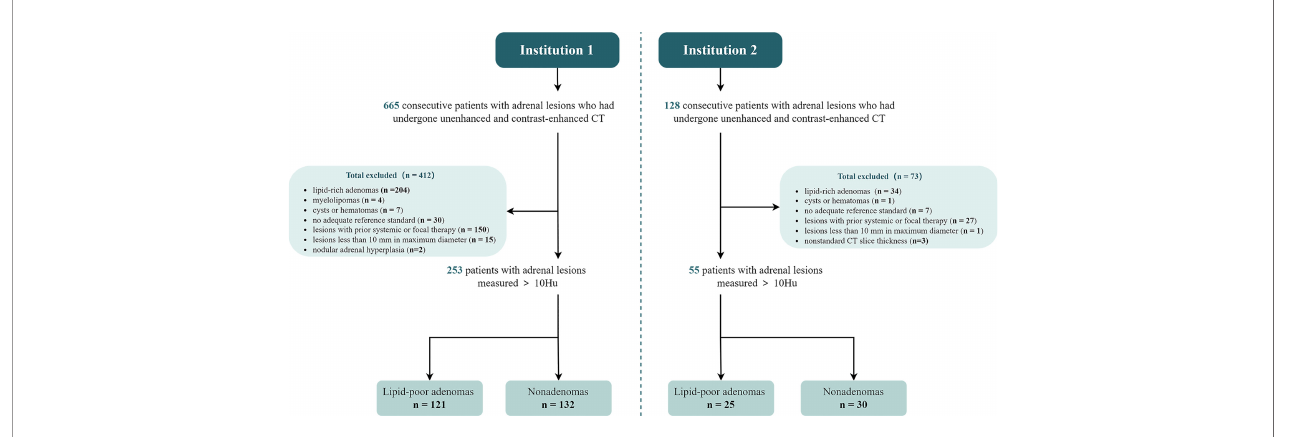
FIGURE 1 | Flowchart of the study